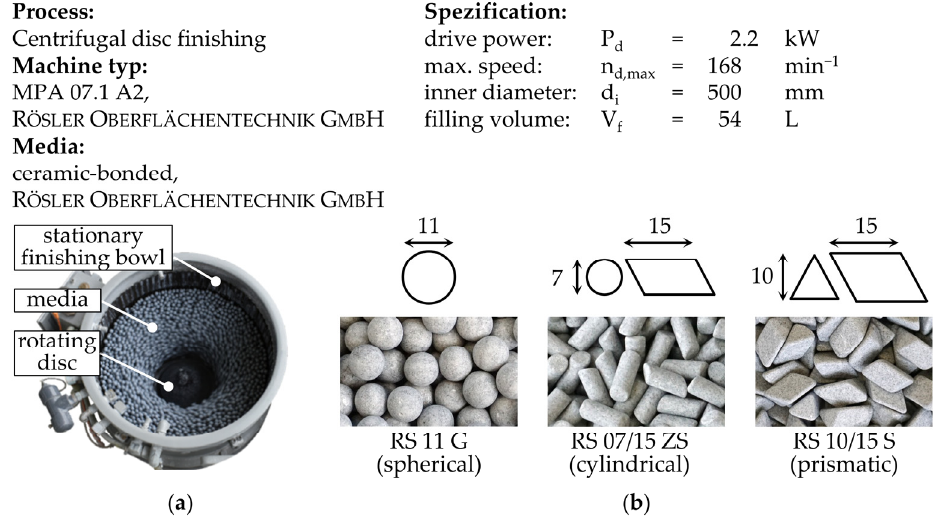
Figure 2. Machining setup: ( a ) finishing machine; ( b ) finishing media.